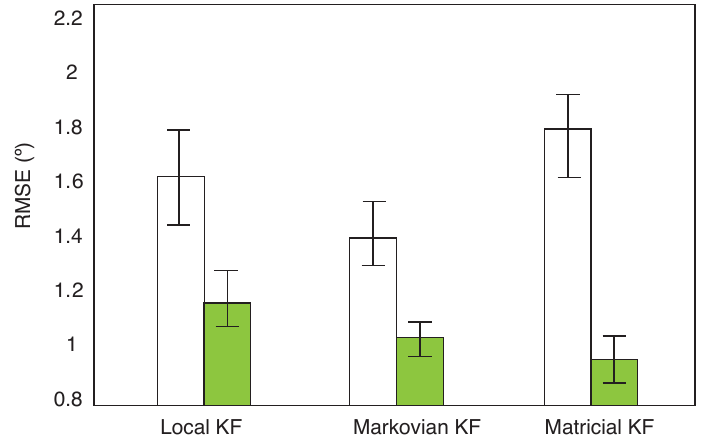
Figure 8. Interaction between the Kalman Filter and calibration. The complex calibration is displayed in green. The bars represent the 95% confidence